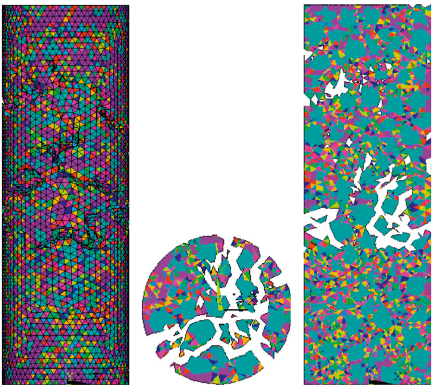
Figure 4: The damagedspecimen and damagedcross sectionof Pre-4.